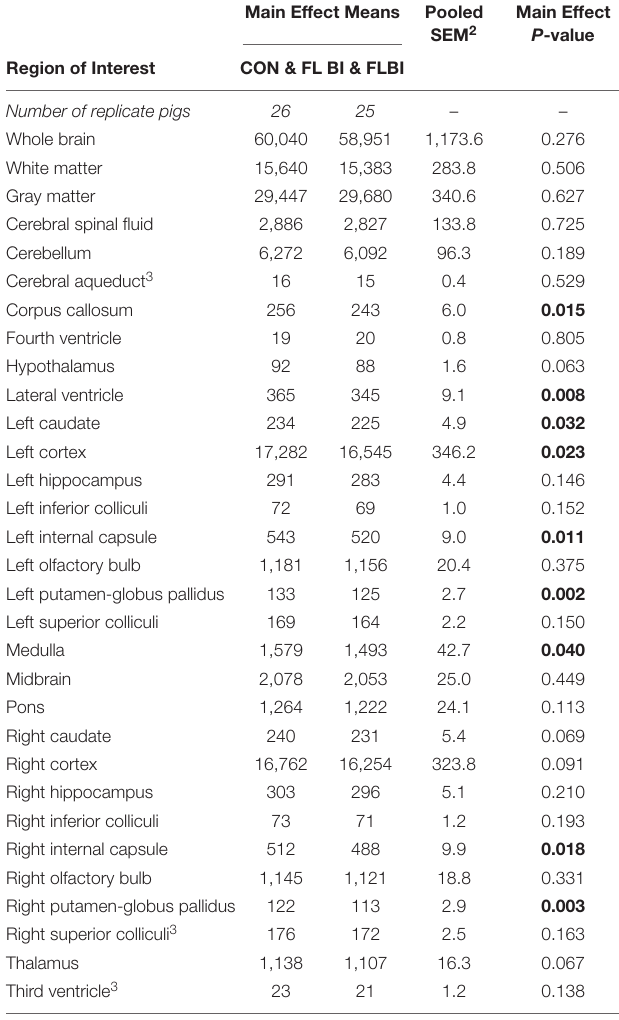
TABLE 1 | Absolute brain volumes (mm 3 ) of pigs receiving milk replacer treatments differing in probiotic supplementation 1